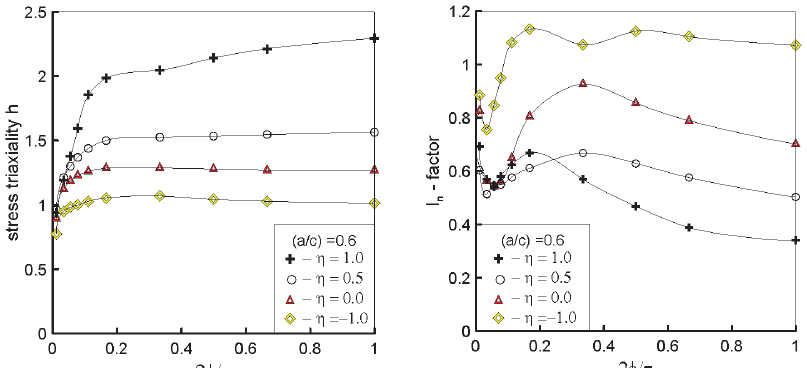
Figure 7: Plastic constraint parameter distributions along crack front under different biaxial loading conditions.